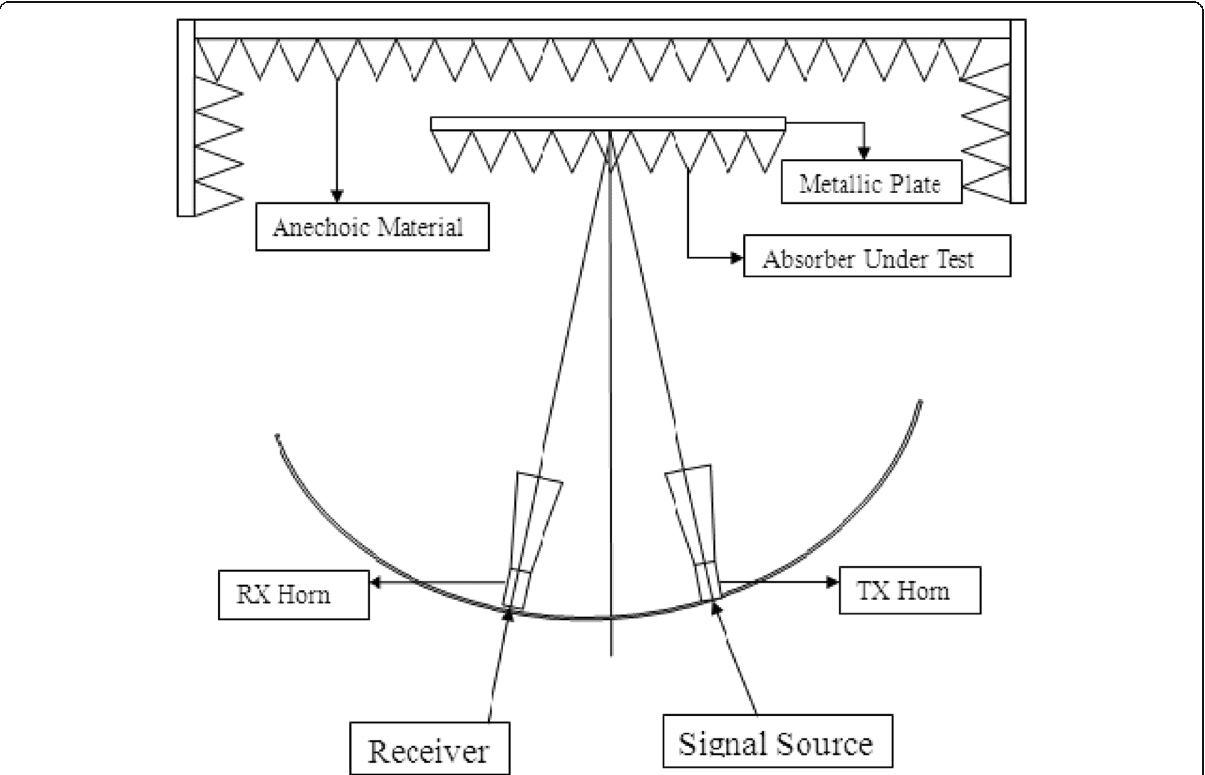
Fig. 5 Schematic of NRL arch method RL measurement setup